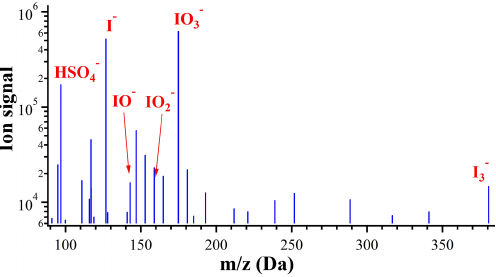
Figure 6. Integrated mass spectrum of molecular ions between retention time 0.5–0.7min of an S13 nano-MOUDI sample (10– 18nm particles). Units (Da) are in